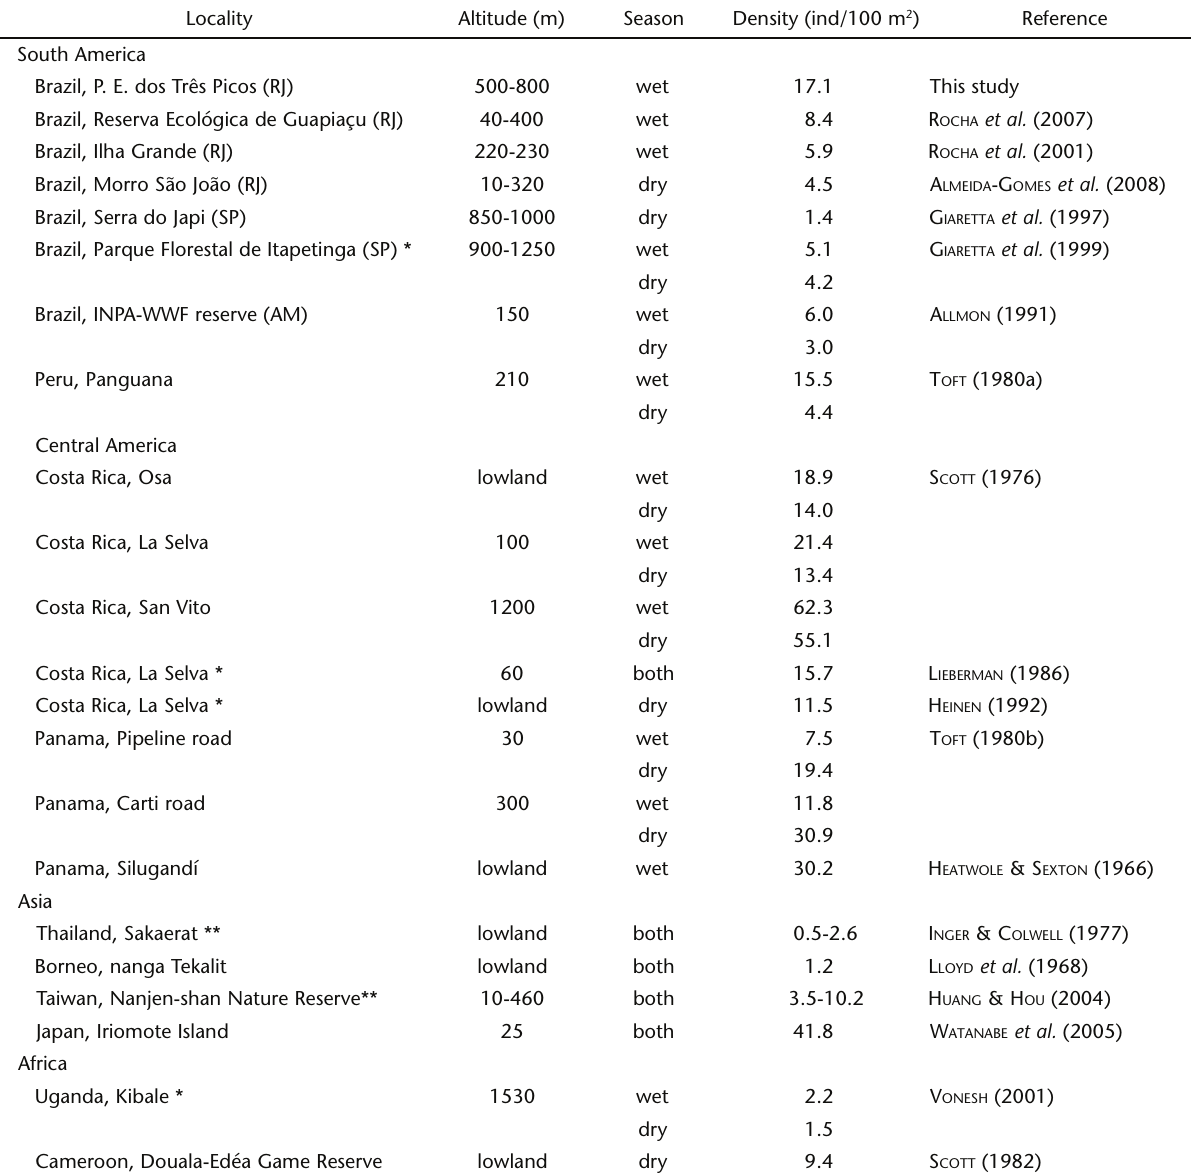
Table II. Summary of data from studies of leaf litter frog assemblages using large-plot (5 x 5 m or larger) sampling in tropical rainforests worldwide. Acronyms for Brazilian states are: (AM) Amazonas, (RJ) Rio de Janeiro, and (SP) São Paulo.